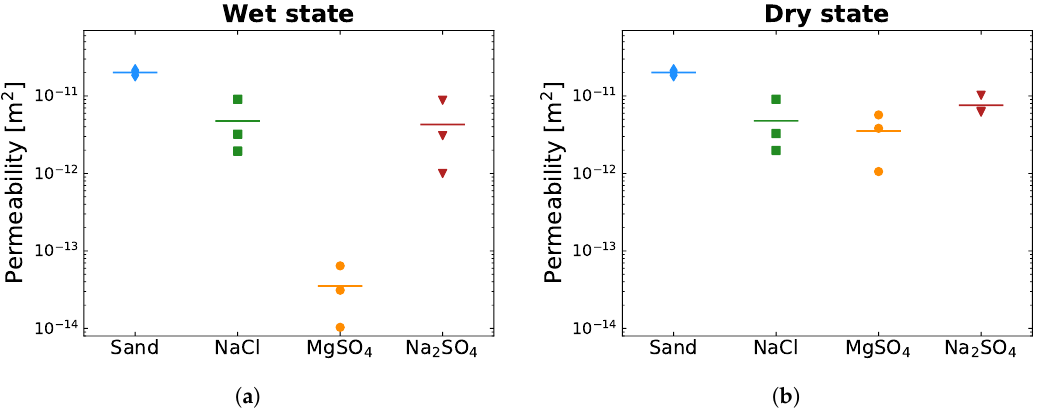
Figure 5. Permeability of different salt crusts determined with the gas permeameter ( a ) directly after evaporation (wet state) and ( b ) after drying for 96 h at 60 ◦ C (dry state). The category “Sand” shows the permeability of the dry reference samples that were prepared with pure water. The data points indicate each individual sample and the horizontal bars show the mean value of each triplicate. The permeability in the wet state ( a ) represents the relative permeability for advective gas flow. As liquid was incorporated in the pores, this permeability has to be handled with care (see text for